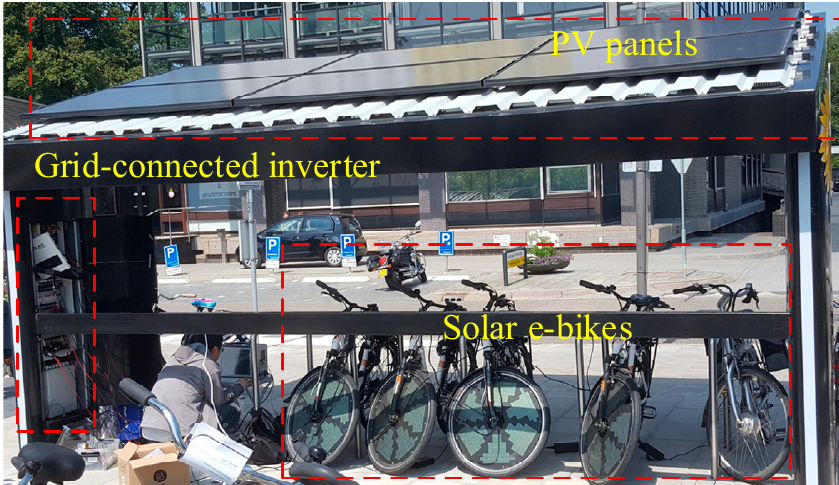
Figure 1. The PV (photovoltaic)charging station with 6 PV modules (top), a grid-connected inverter (at left column), and 4 solar e-bikes that are being